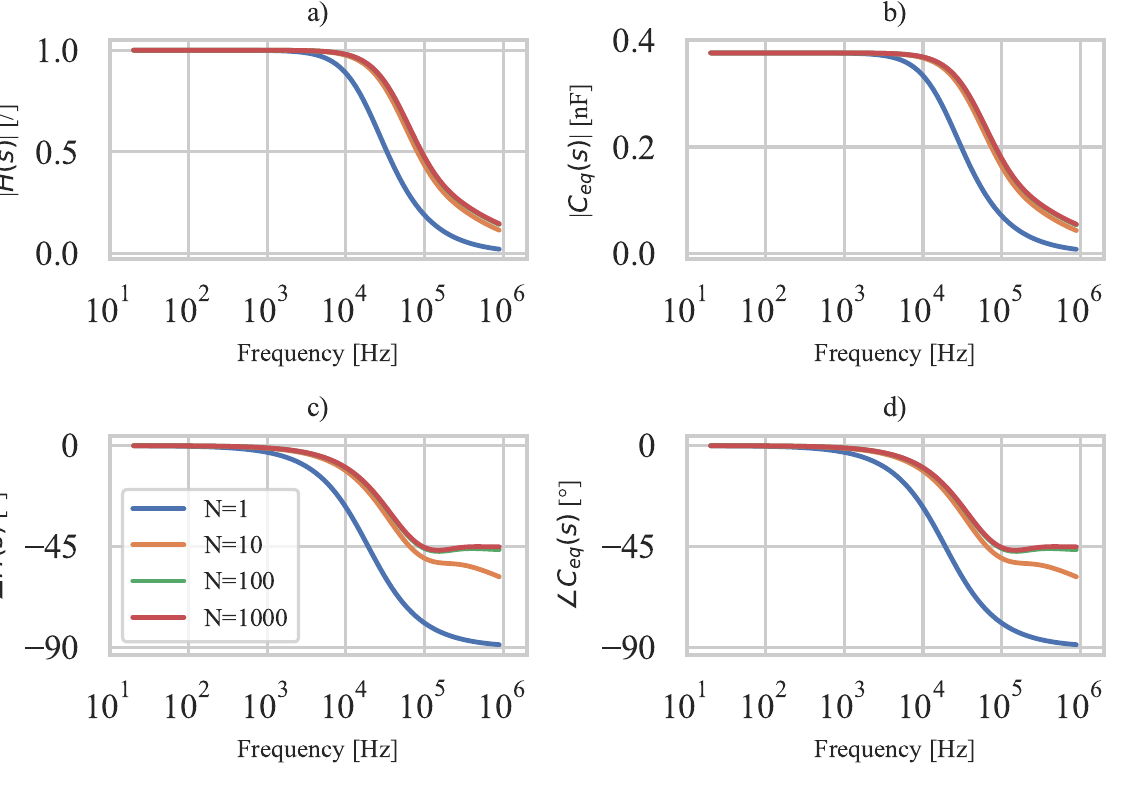
Figure 5. The 3D-printed sensor characteristics for different N : ( a ) H ( s ) amplitude spectrum, ( b ) C eq ( s ) amplitude spectrum, ( c ) H ( s ) phase spectrum, ( d ) C eq ( s ) phase